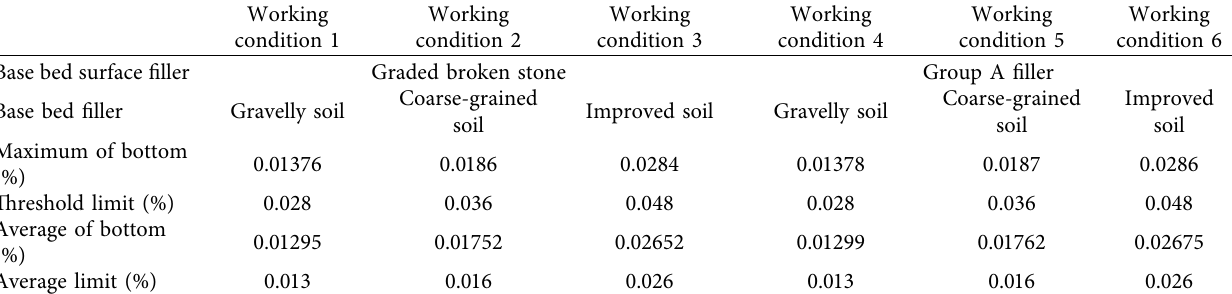
Table 6: Reasonable thickness of different bed